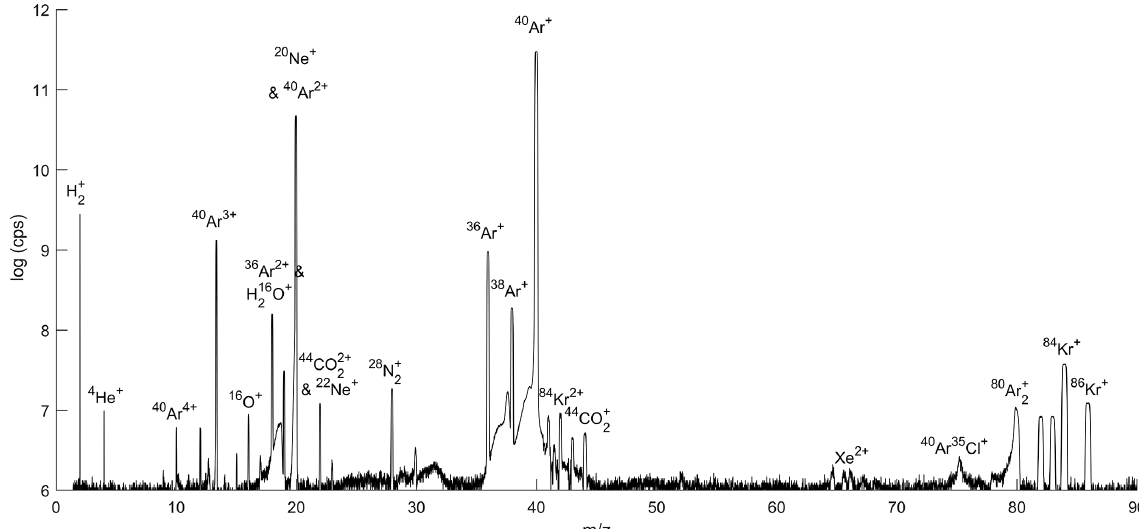
Figure 4. Mass scan of ambient air. Ion beam intensity is shown as the logarithm of the ions counted per second, and select ion species are